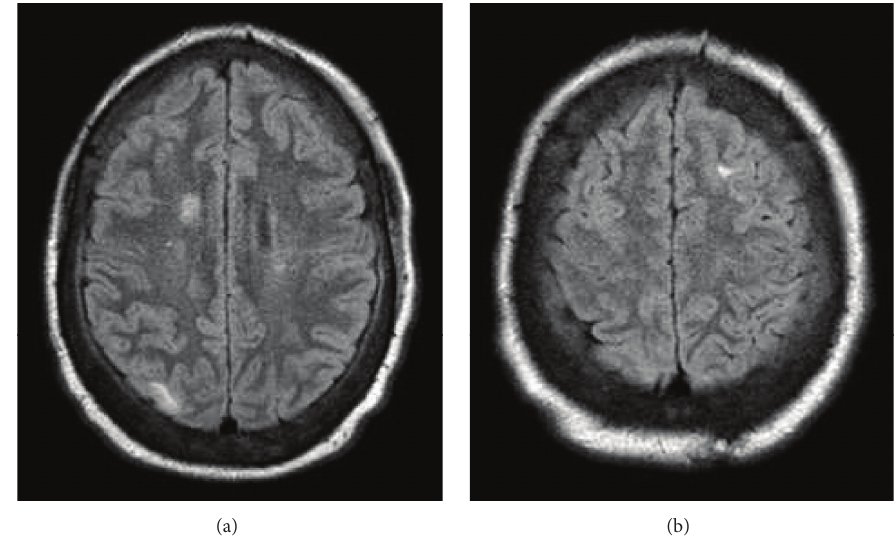
Figure 3: T2 FLAIR axial MRI showing subcortical areas of mixed signal mass in the right occipital cortex (a) and left frontal cortex (b), suggestive of cortical